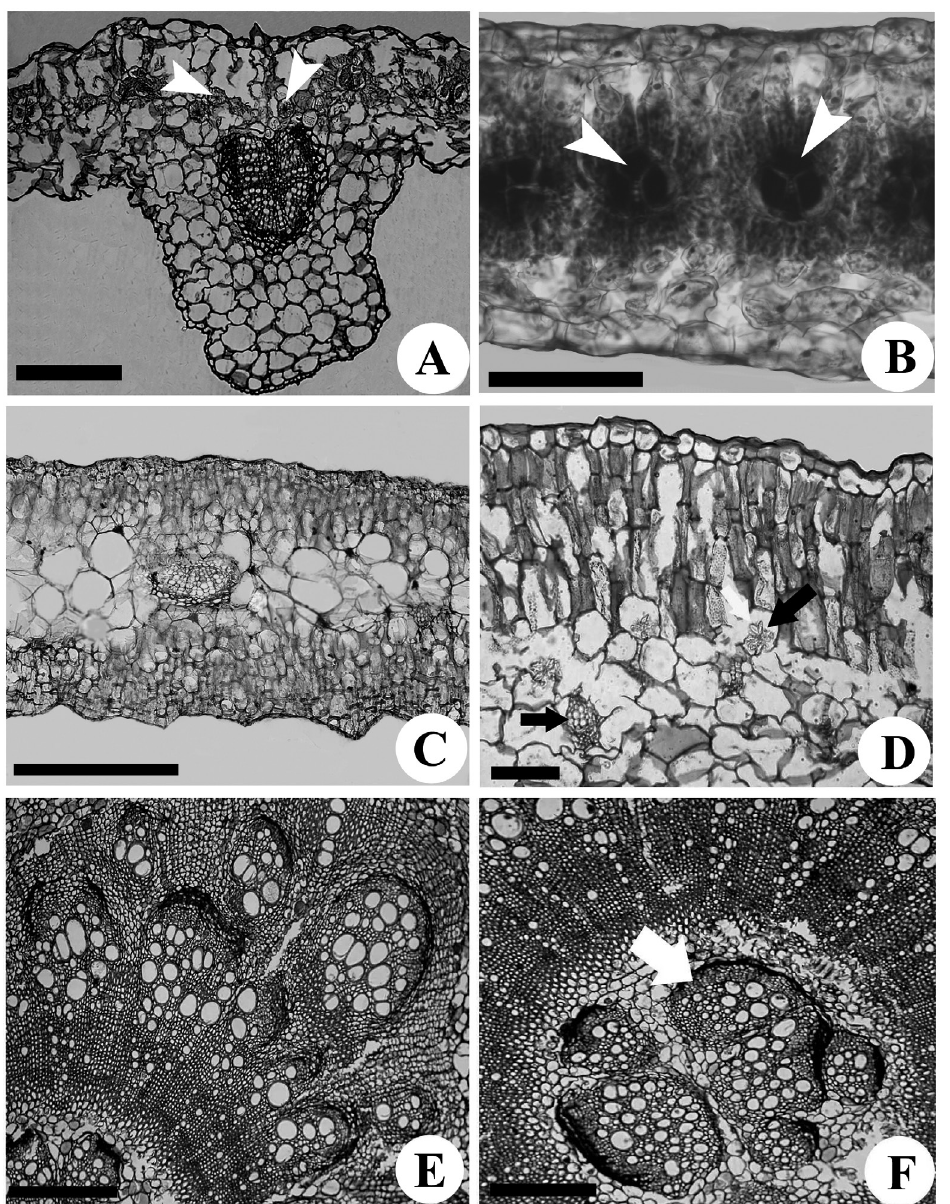
FIGURE 3 - Transverse view of Trianthema portulacastrum and Sesuvium portulacastrum leaf (A-D) and Boerhaavia diffusa stem (E-F) showing structural variations. A: Trianthema portulacastrum leaf showing midrib portion with single vascular bundle, irregularly arranged parenchyma cells. Arrowheads indicate druces. B: Leaf lamina region of Trianthema portulacastrum L. showing bundle sheaths (arrowhead). C: Sesuvium portulacastrum leaf showing isobilateral orientation of leaf, four layered palisade tissue, single vascular bundle in midrib region. D: Enlarged view of Sesuvium portulacastrum showing lateral vascular bundle (small arrow) in lamina and druces (arrow). E: Boerhaavia diffusa stem showing successive rings secondary xylem. F: Pith region of Boerhaavia diffusa stem showing medullary bundles